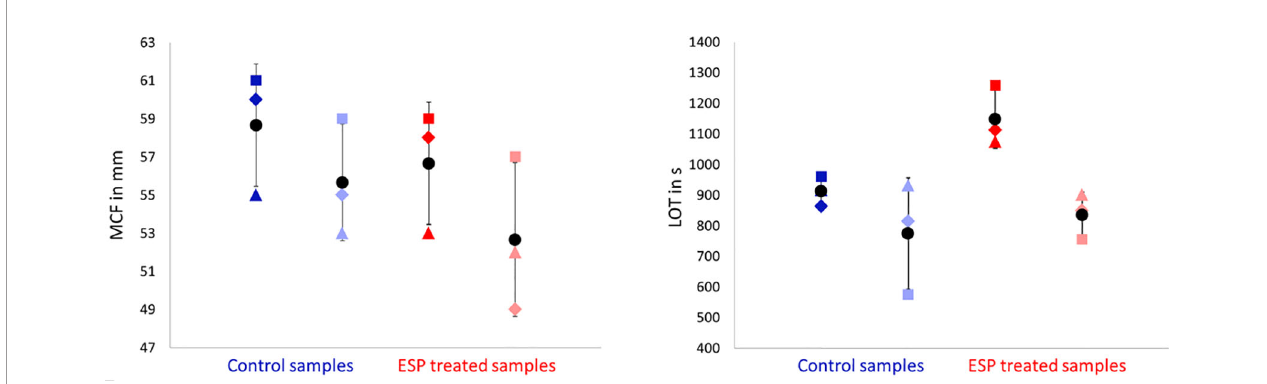
FIGURE 7 | Rotational thromboelastometry (ROTEM) EXTEM MCF (maximum clot fi rmness, in mm, left side) and LOT (lysis onset time, in s, right side) parameters did not change signi fi cantly upon varying sample treatments. ESP treated blood samples (in red) contained 10 m g/ml Angiostrongylus vasorum excretory/secretory protein, control blood samples (in blue) contained PBS. Dark blue and dark red symbols indicate no incubation, light blue and light red symbols indicate 1 h incubation (at 37°C). Means (round symbol in black) and standard deviations were calculated based on the measurements from three dogs (dog M: triangle, dog N: square, dog O: diamond).